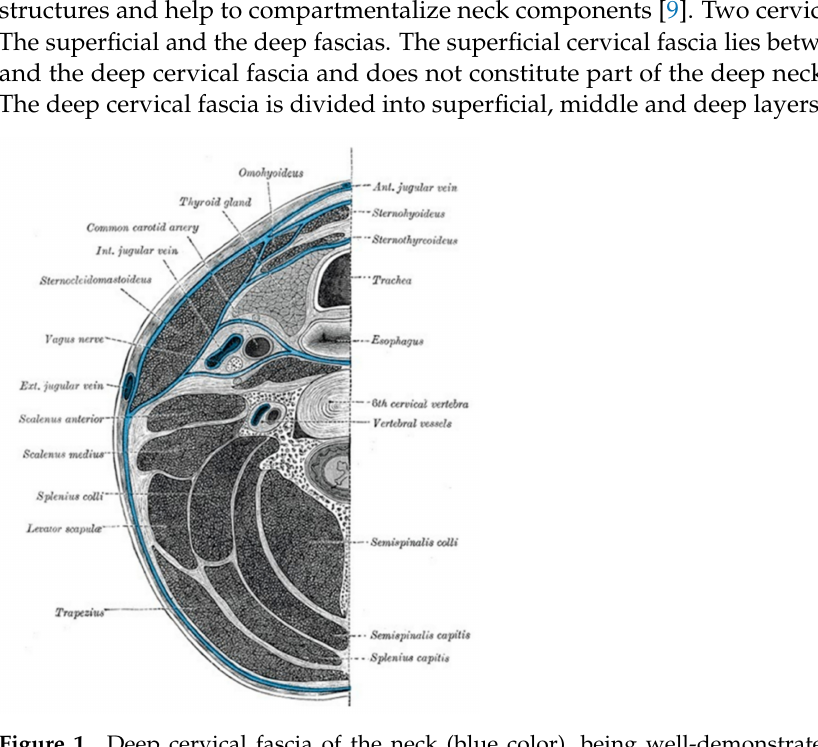
Figure 1. Deep cervical fascia of the neck (blue color), being well-demonstrated by this trans- verse section at the level of the sixth cervical vertebra. Licensed under CC by 4.0. Available from: https://www.ncbi.nlm.nih.gov/books?term=transverse%20section%20of%20the%20neck% 20AND%20book_statpearls[sb]&report=imagesdocsum (Accessed on 18 March